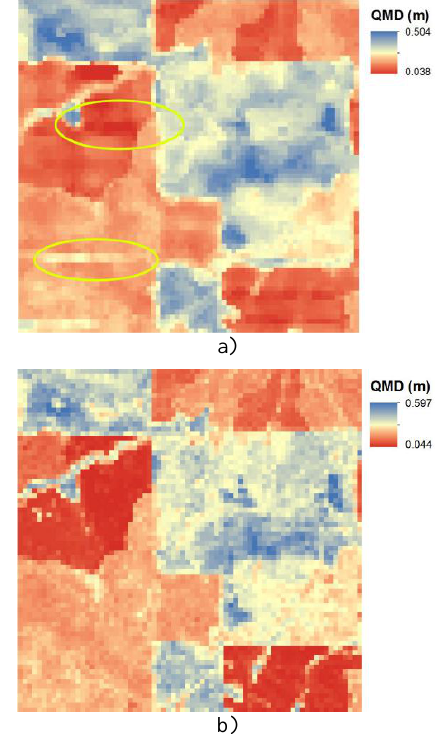
Figure 6. Estimation of quadratic mean diameter (QMD) for a small zone of the study area using (a) 0.25m-maximum (the effect is evident in some flight lines), and ( b ) 2m-mean